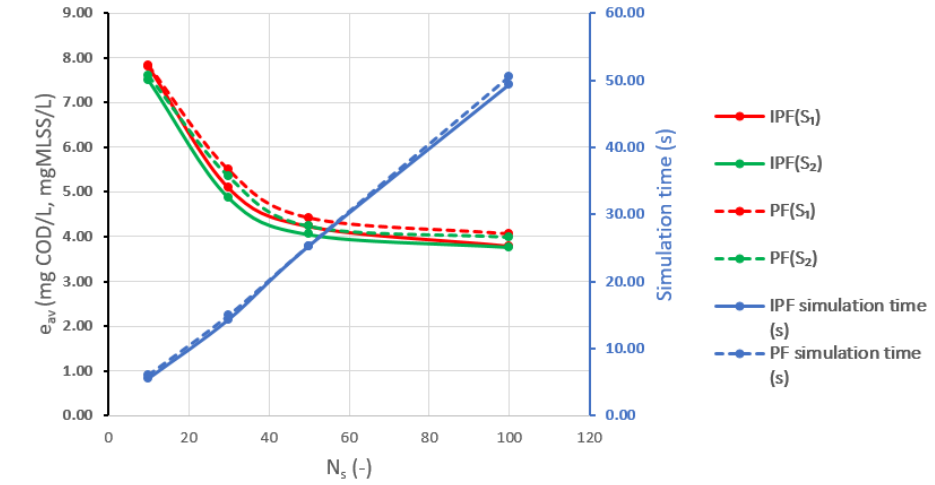
Figure 7. Comparison of PF and IPF: the estimation errors ( e av ) of the substrate concentrations and the simulation time regarding the different numbers of particles. The curves belonging to PF are represented by dashed lines and those belonging to IPF by continuous ones. The red and green colors refer to the S 1 and S 2 state variables, respectively. The other parameters are the same as before ( N S = 10, 30, 50, 100; T = 4000; N r =